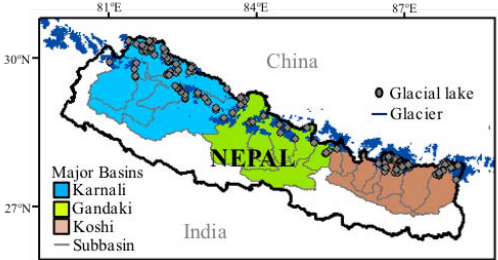
Figure 1. Study area showing glacial lakes and glaciers in Nepal along with major basins and subbasins adapted from ICIMOD (2011) [24].